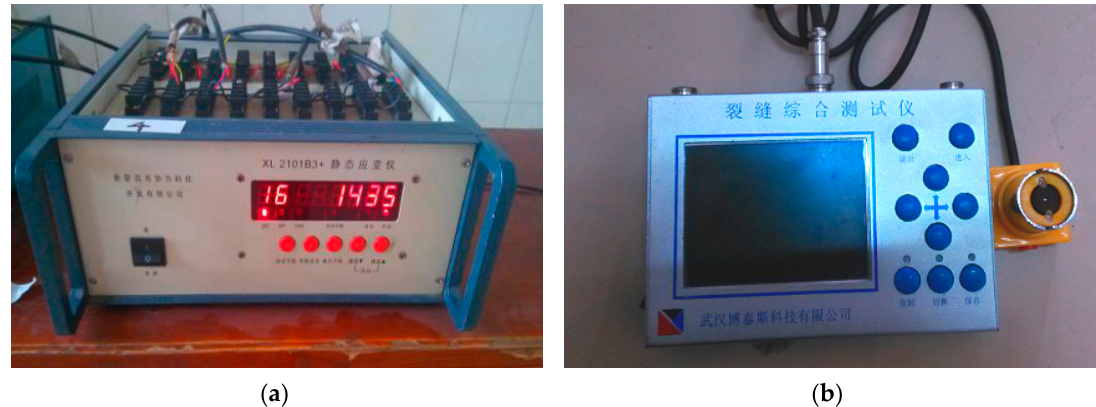
Figure 8. Instruments for the plat-ring-type test: ( a ) static strain testing device; ( b ) crack testing device.